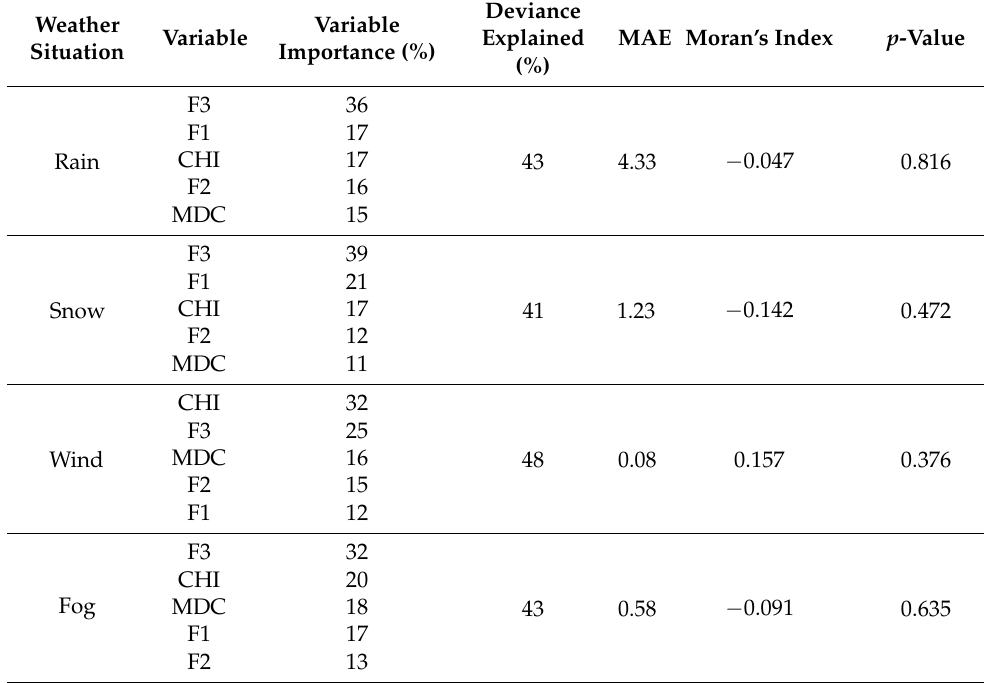
Table 4. Summary statistics for the decision tree